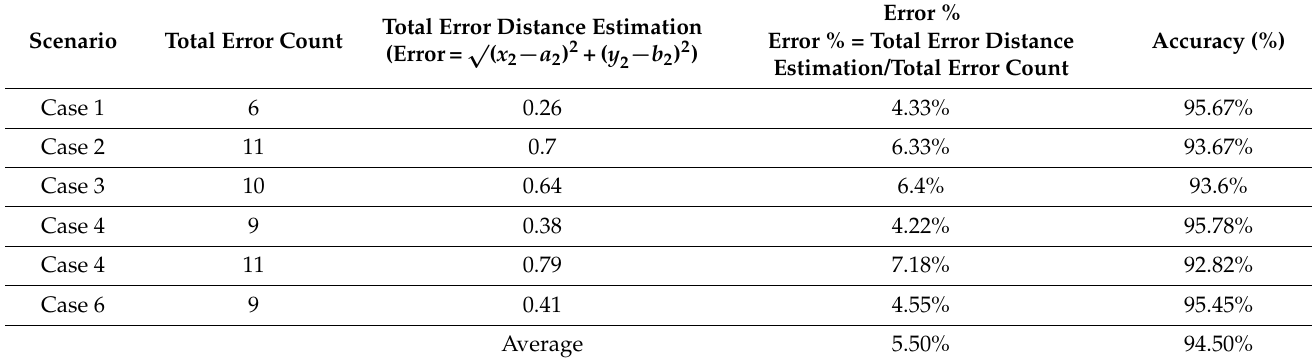
Table 5. Quantitative analysis used to calculate the accuracy using the proposed method (RL).